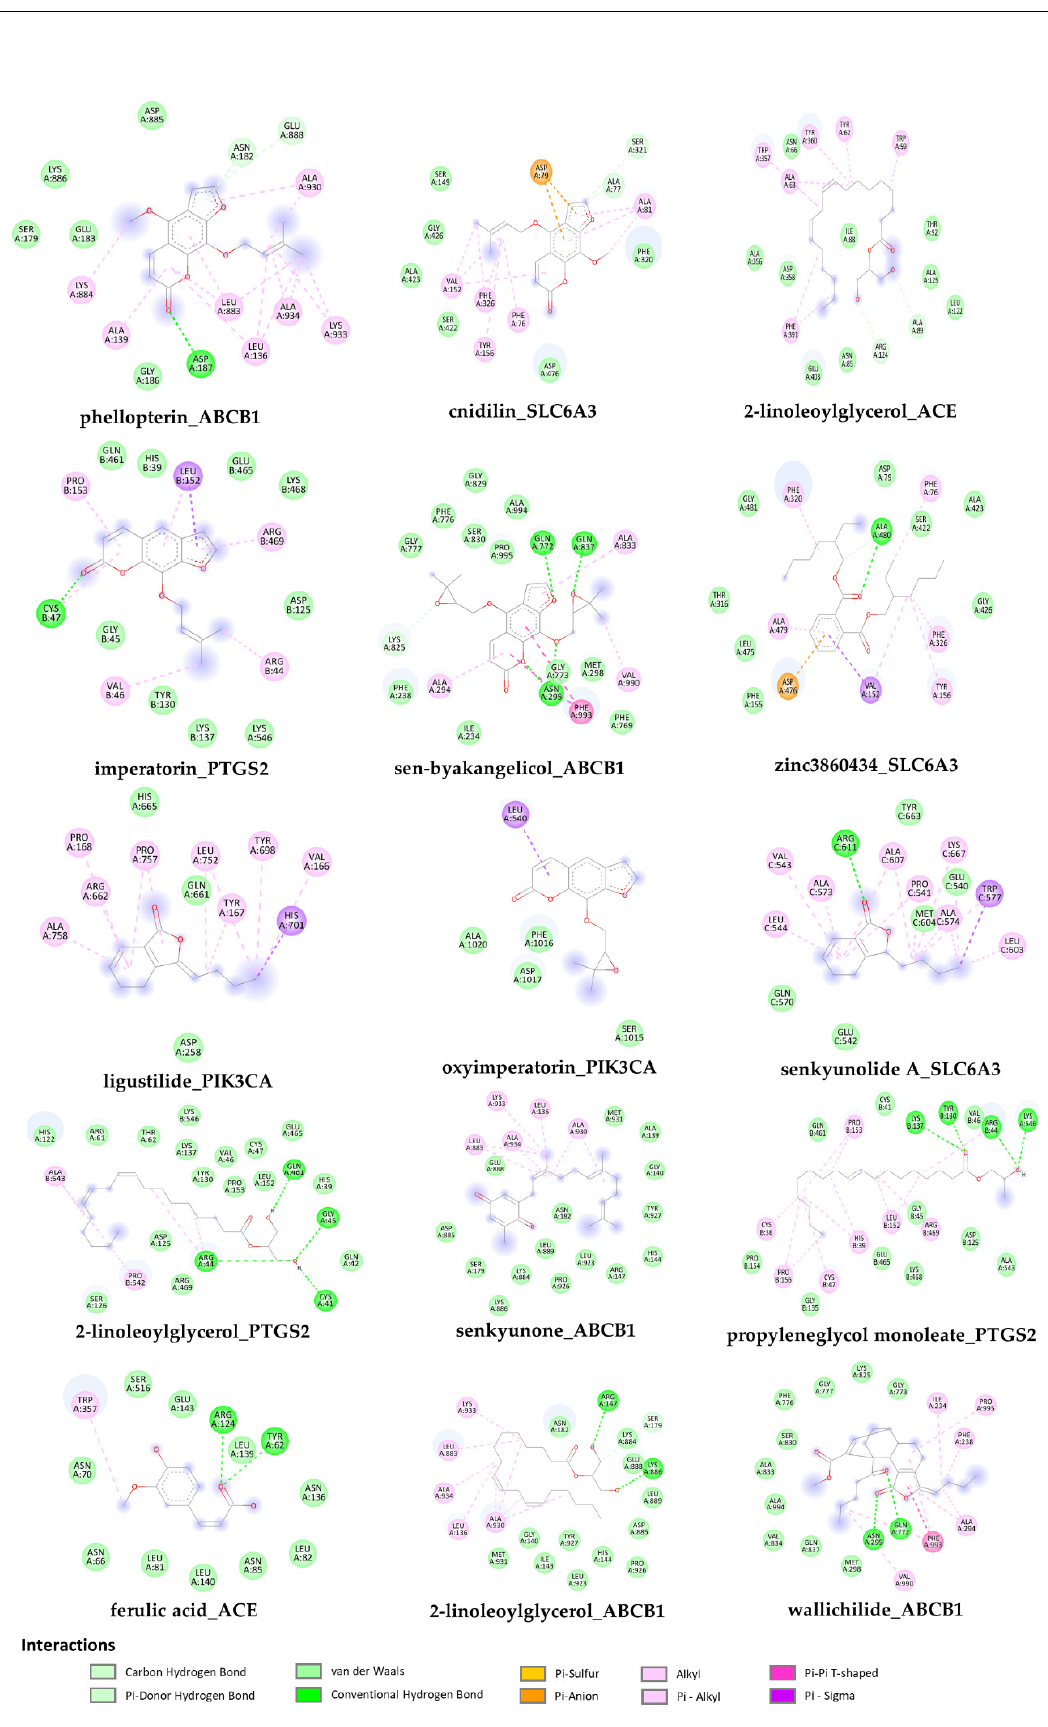
Figure 8. Two-dimensional visualization data of the compound–protein complex in the docking study.